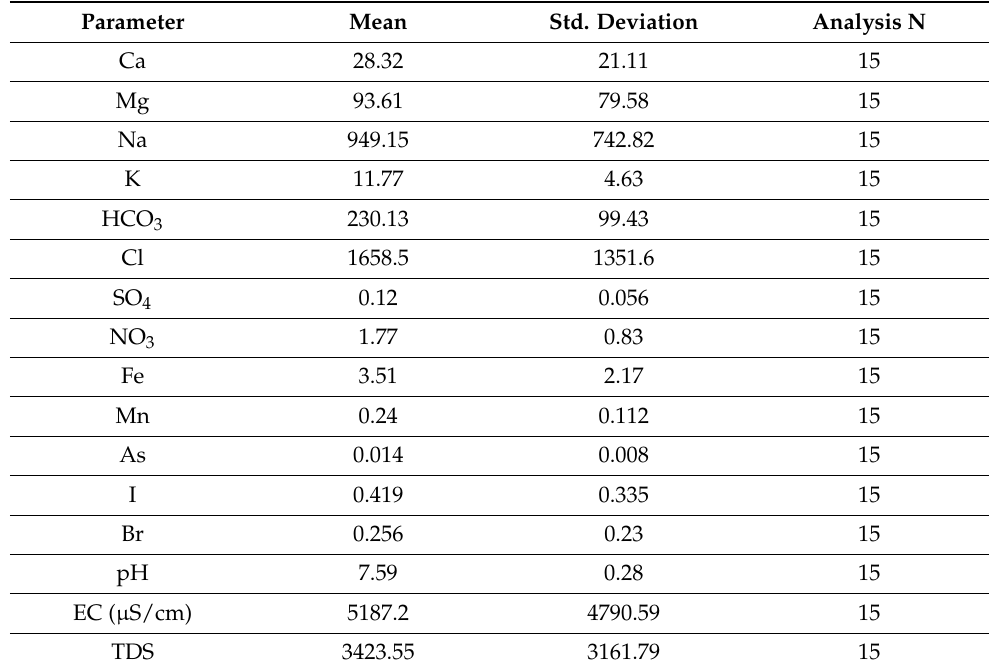
Table A2. The mean and standard deviation of groundwater